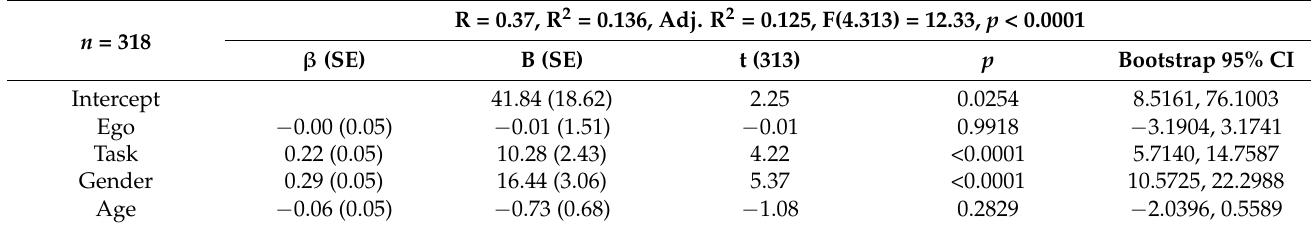
Table 7. Regression model for the declared time of one session of physical activity (in minutes). n =